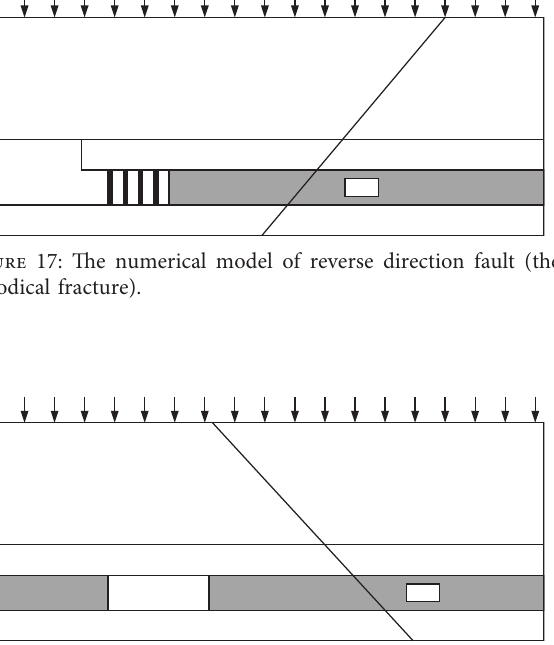
Figure 18: The numerical model of forward direction fault (the initial fracture).